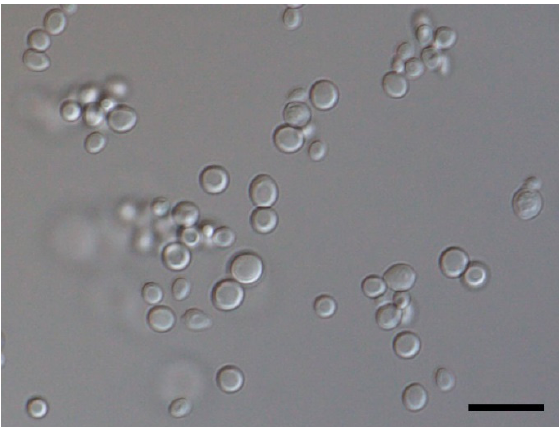
Figure 4. Micrograph showing isolated cells of the yeast C. palmioleophila (scale bar = 10 μ m). The sequence similarity between CGMHD 2210 and C. palmioleophila type strain ATCC 96299 was 100% for ITS and LSU , 99% for TEF1a , and 98% for RPB1 . Figure 5 shows